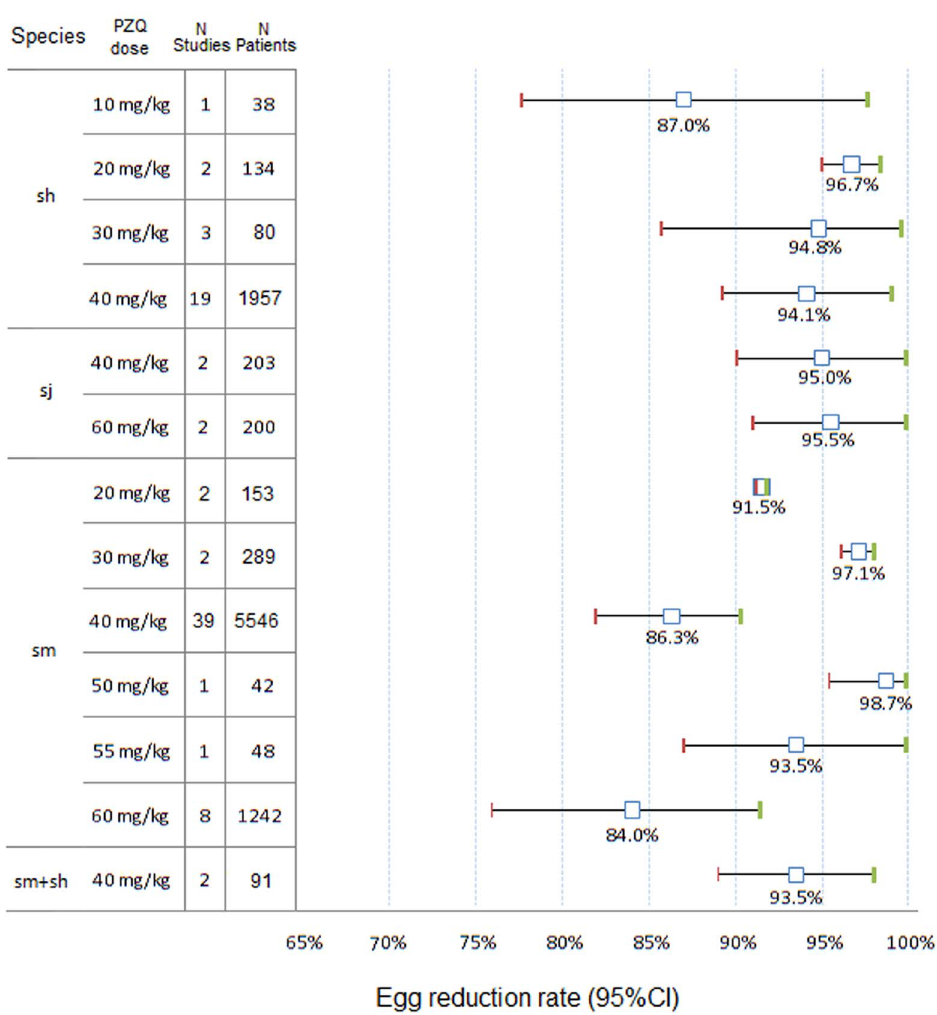
Figure 6. PZQ egg reduction rates with 95% CIs by species and dose. ci, confidence interval; sh, S. haematobium ; si, S. intercalatum ; sj, S. japonicum ; sm, S. mansoni